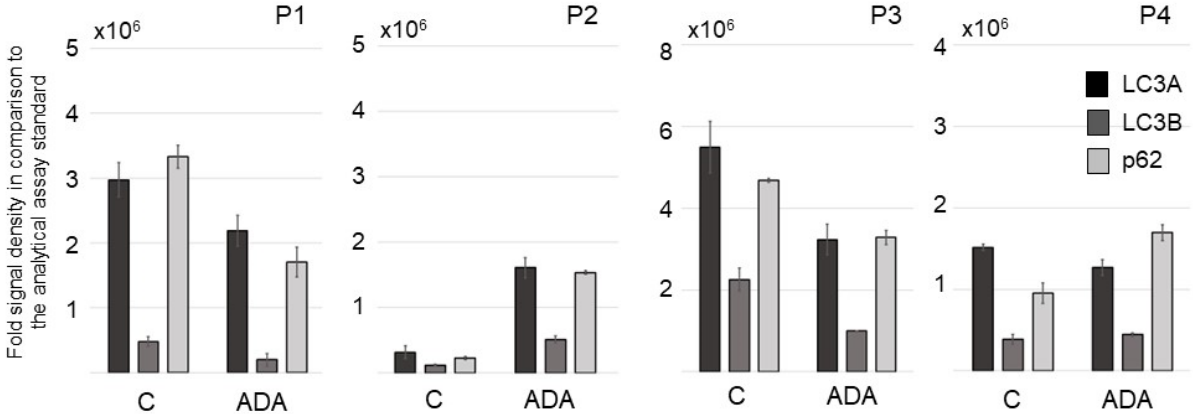
Figure 5. Comparative expression of the levels of the pro-apoptotic proteins LC3A, LC3B, and p62 in three patients with HS Hurley stage II (P1-P3) and one patient with HS Hurley III (P4) in HS lesional skin of the control group (C) and the adalimumab-treated group (ADA) maintained for 3 days in the HS 3D-SeboSkin model. Comparisons were performed against the analytical assay standards.